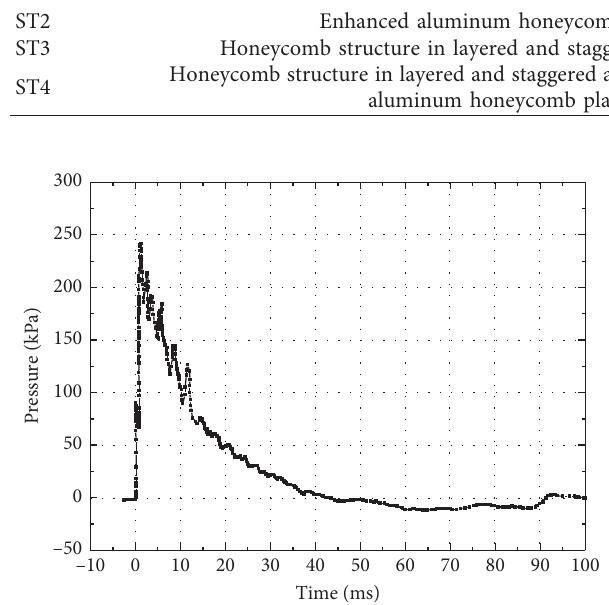
Figure 10: Pressure time-history curve of explosion shock